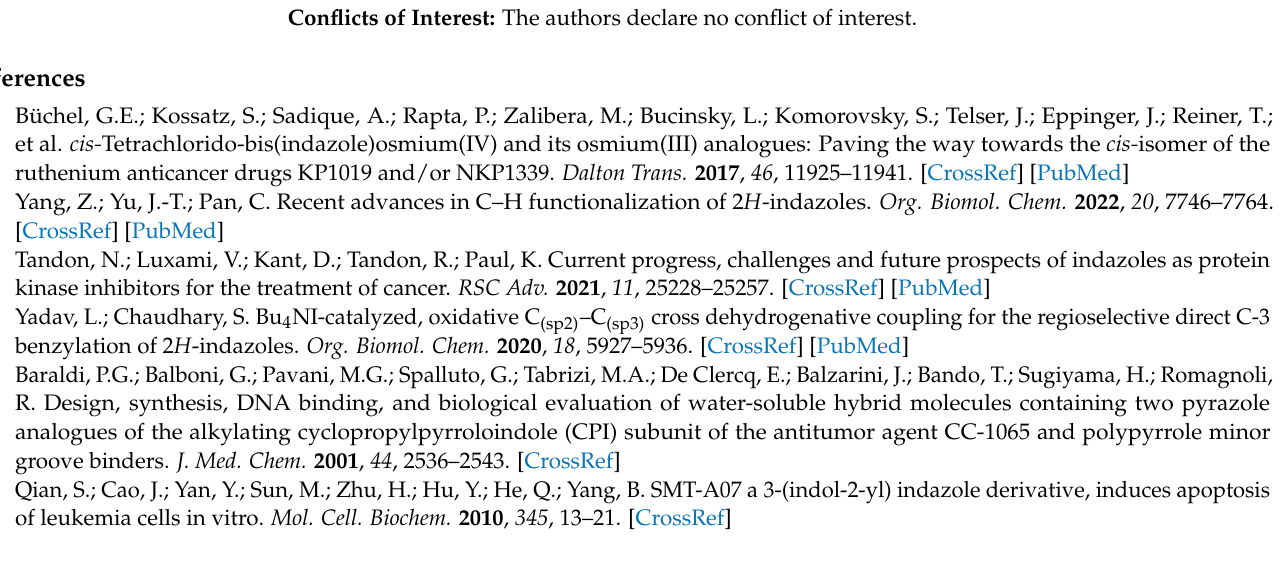
(Figure S23); Section S24: 1 H NMR spectrum of 3-(1 H -indazole-3-yl)benzoic acid (compound 12 ) (Figure S24); Section S25: 13 C NMR spectrum of 3-(1 H -indazole-3-yl)benzoic acid (compound 12 ) (Figure S25); Section S26: ESI-HRMS (TOF-SIMS) of 3-(1 H -indazole-3-yl)benzoic acid (compound 12 ) (Figure S26); Section S27: Optimized structures from